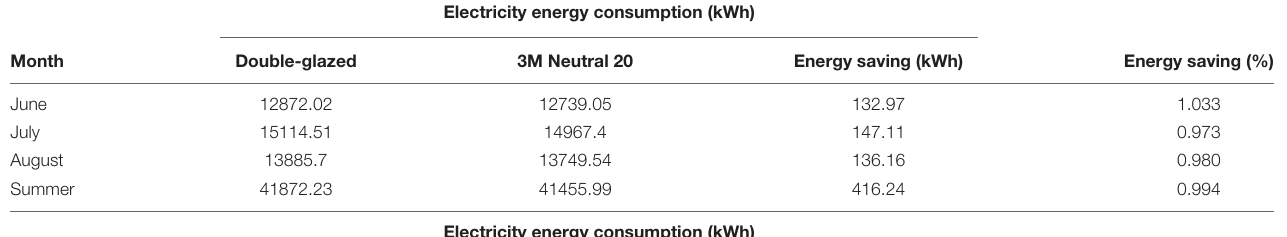
TABLE 8 | Electrical energy saving (kWh) using window films in summer 2019 in Kuwait.